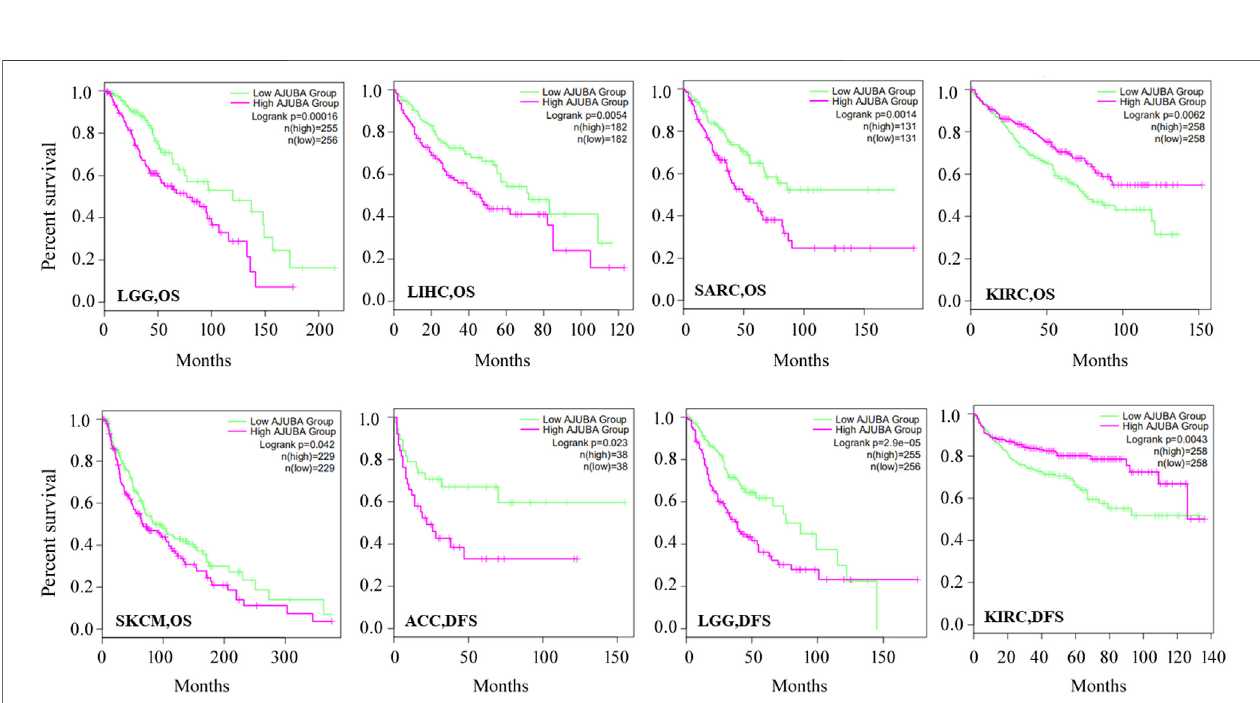
FIGURE 3 | Using the gene expression pro fi ling interactive analysis 2 (GEPIA2) database (http://gepia.cancer-pku.cn/), correlation between the AJUBA gene expression and survival prognosis of LGG, LIHC, sarcoma (SARC), KIRC, SKCM, and adrenocortical carcinoma (ACC) was displayed with the overall survival (OS) or disease-free survival (DFS) curves.